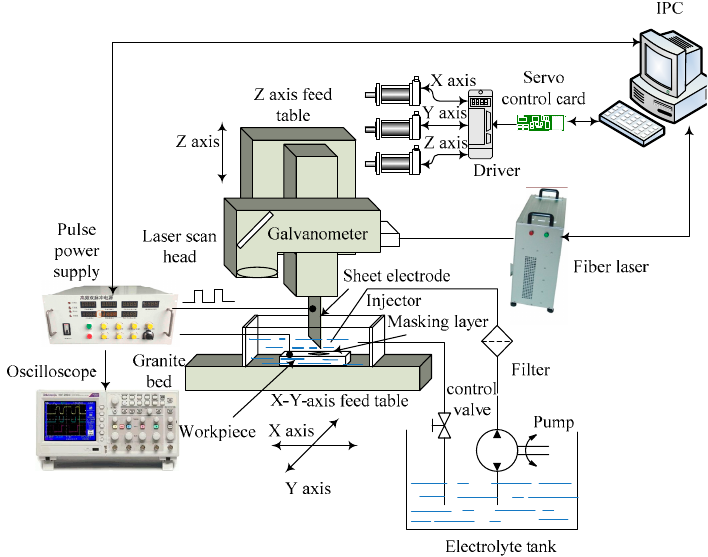
Figure 2. The developed device for electrochemical micromachining with fiber laser mask.